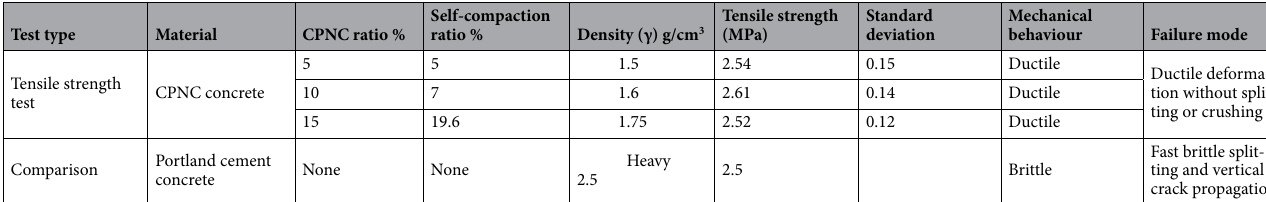
gation of tested sample. Fracture properties, including fracture toughness (K Ic ), fracture energy (G f ), type of fracture and fracture mode, have been investigated for standard tests of notched beams under three-point loads, including pre-crack at bottom edge (single edge notch beam (SENB) tests). Results are shown in Table 4 and Fig. 4a,b. Fracture toughness 12–17,41,45 or critical stress intensity factor K Ic , as shown in Eqs. (2) and (3), is a func- tion of critical applied load (σ c ), half notch length (a) and beam geometry and dimensions: